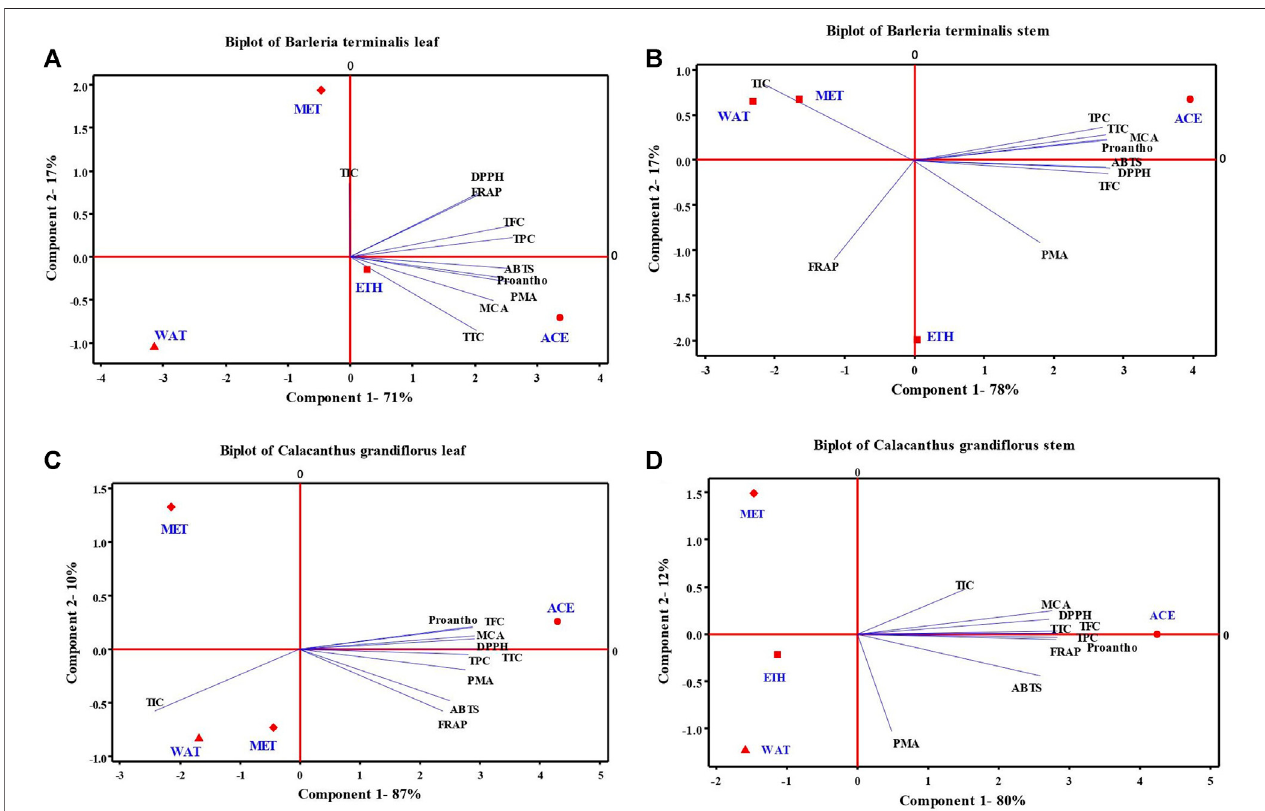
FIGURE 2 | Principal component analysis (scores and loading plots, biplot) depends on several phytochemical compounds analyzed in four different leaves and stemextractof B.terminalis (A,B) andC. grandi fl orus (C,D) withtheirantioxidantactivities(DPPH,ABTS,FRAP,PMA,andMCA).TPC,totalphenoliccontent;TFC,total fl avonoid content; TTC, total tannin content; Proantho, Proanthocyanidins content; TIC, total iridoid content.